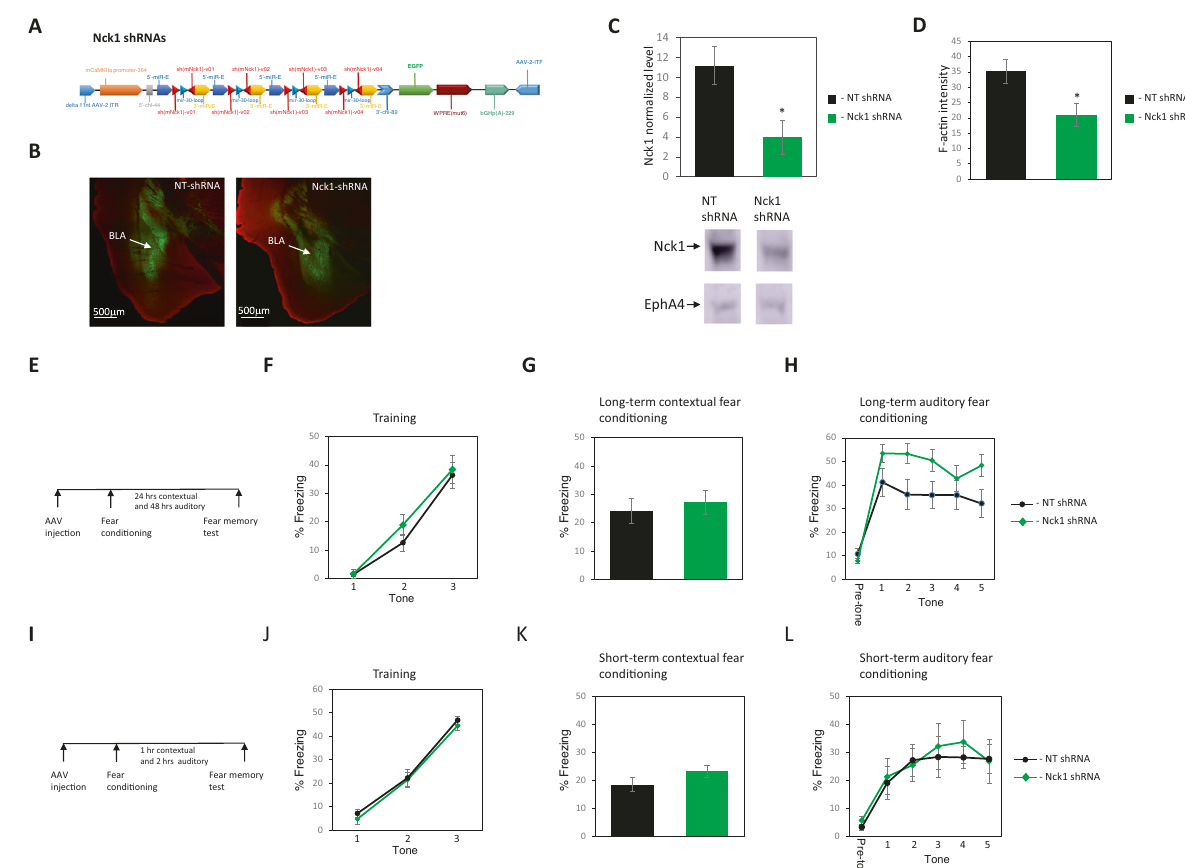
Fig. 1 Reduction of Nck1 in excitatory neurons in lateral amygdala impairs long-term memory formation. A 21-mer short/small hairpin shRNA sequences that are selected speci fi cally against the mouse Nck1 and are embedded in a human microRNA-30 (miR-E) were used in the study. B Nck1 shRNAs or control non-targeting (NT) shRNAs are expressed in the basolateral amygdala (BLA) as shown by the EGFP that is co- expressed with the shRNAs. C Nck1 shRNAs ( n = 3) signi fi cantly reduces the level of Nck1 in the lateral amygdala when compared to NT shRNAs control ( n = 3) ( p = 0.048). A representative blot is shown. D F-actin level is reduced in Nck1 shRNA expressing neurons when compared to F-actin level in neurons expressing NT shRNA ( t (10) = 2.517, p = 0.031). E Description of the long-term behavioral protocol. F Freezing during fear conditioning training is not different between the Nck1 shRNA and NT shRNAs groups ( F (1,19) = 0.556, p = 0.456). G Freezing during the long-term contextual fear memory test is not different between the Nck1 shRNAs and NT shRNAs groups ( t (0.523) = 0.19, p = 0.607). H Reduced Nck1 in LA ( n = 10) enhanced long-term auditory fear memory formation in LA when compared to the control group ( n = 11) ( F (1,19) = 4.492, p = 0.047). I Description of the short-term behavioral protocol. J Freezing throughout the tones presentations during training of animals used in the STM experiment that expressed Nck1 shRNAs or control NT shRNAs was analyzed. There is no signi fi cant difference between the groups ( F (1,12) = 0.576, p = 0.462). K Contextual fear conditioning tested 1 h after fear conditioning is not different between the Nck1 shRNAs ( n = 7) and control NT shRNAs ( n = 7) groups ( t (12) = 1.456, p = 0.171). L Auditory fear conditioning tested 2 h after fear conditioning is not different between animals injected with shRNAs against Nck1 compared to NT shRNAs injected mice ( F (1,12) = 0.077, p = 0.786). Values are mean ± SEM. C , D Independent samples t -test; F – H and J – L Repeated measures removed at the end of the last light stimulation. Light stimulation ( n = 12 cells) ( t (22) = 3.367, p = 0.003) (Fig. 2B). It was shown that led to a signi fi cant increase in PA-Nck1 clusters (normalized to Nck clustering leads to localized actin polymerization [25]. fl uorescence intensity) in LA neurons ( n = 14 neurons from 8 Moreover, actin is co-localized with CRY2olig – mCh – Nck clusters animals) compared to no-stimulation neurons ( n = 14 neurons in COS-7 [34]. We stimulated HEK293 cells as above and stained it from 6 animals) ( t (28) = 2.744, p = 0.01) (Fig. 2E). Thus, the with the F-actin binding compound phalloidin. As seen in Fig. 2C PA-Nck1 is co-localized with F-actin in multiple spots in light application of blue light leads to a rapid increase in PA-Nck1 stimulated HEK293 cells. Moreover, we detected an increase in clusters in LA. We next studied whether the increase in PA-Nck1 F-actin clusters (normalized to fl uorescence intensity) after blue clusters leads to an increase in clusters where PA-Nck1 is co- light stimulation ( n = 7 cells) compared to cells stored in the dark localized with F-actin. We revealed that application of light to LA ( n = 6 cells) ( t (11) = 2.367, p = 0.036) (Fig. 2C). Next, we examined leads to a signi fi cant increase in PA-Nck1 and F-actin co- localization in light treated neurons ( n = 10 neurons from 5 whether PA-Nck1 can form clusters after blue light stimulation in animals) compared to no light neurons ( n = 10 neurons from 4 pyramidal neurons in lateral amygdala (LA). We, therefore, cloned animals) ( t (18) = 2.158, p = 0.045) (Fig. 2F). PA-Nck1 downstream to short CaMKII promoter in AAV to express it in excitatory pyramidal neurons in LA [35]. PA-Nck1 is expressed We next expressed PA-Nck1 in excitatory neurons in LA of mice in LA after AAV injection (Fig. 2D). We applied blue light (473 nm) and applied blue light during tone (CS)-shock (US) presentations on the LA through optic fi ber using the same light intensity and (Fig. 3A). There is no effect on fear conditioning training duration used in the behavioral paradigm. The brains were ( F (1,21) = 0.138, p = 0.714) and treatment × tone trial interaction